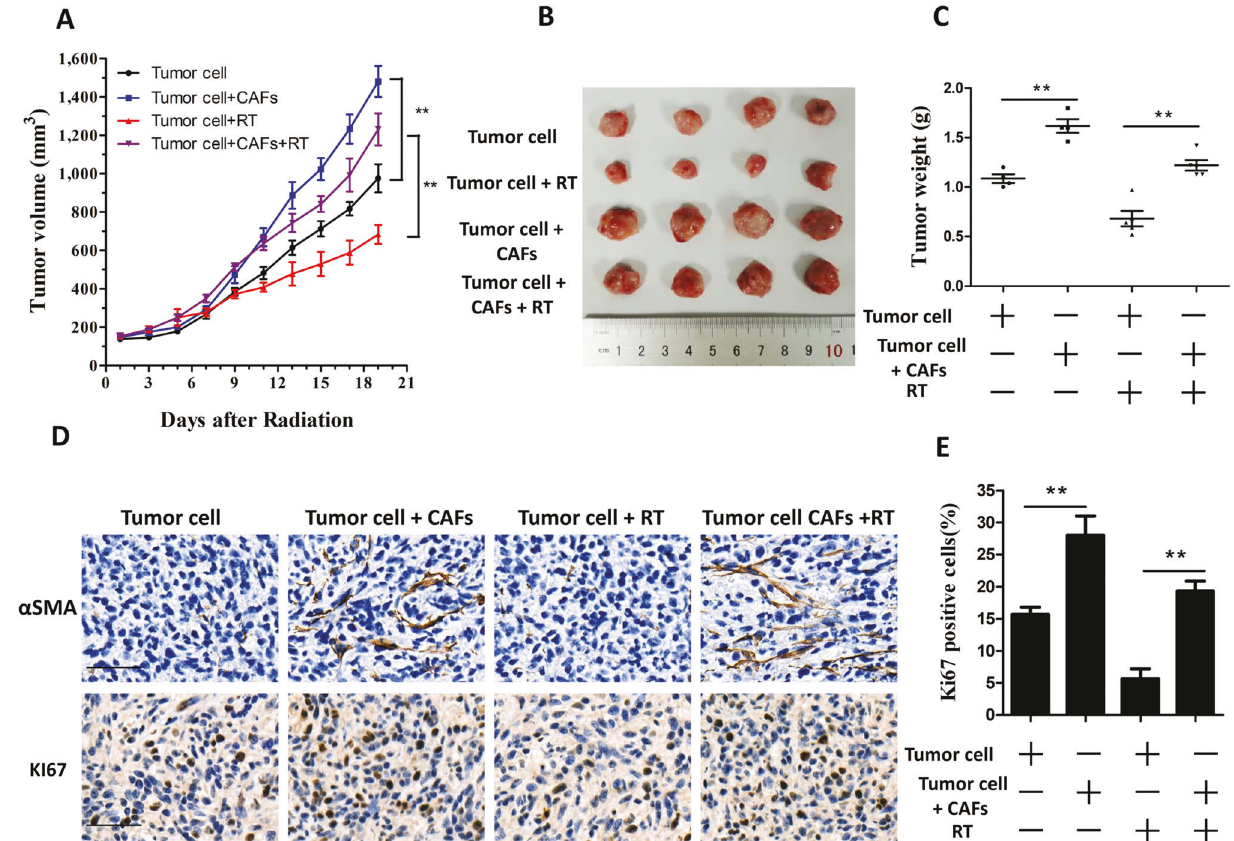
Fig. 2 CAFs facilitated the radioresistance and growth of breast cancer cells in vivo. A MDA-MB-231 cells (1 × 10 5 ) alone or mixed with CAFs (4 × 10 5 ) were implanted into the right limb of nude mice. When the tumors grew to 150 mm 3 , the tumors were exposed daily to 2 Gy radiation for fi ve treatments. The tumor volume was monitored every 2 days. Data points indicate the average tumor volume (mm 3 ) in each group ( n = 4); bars, SE. * P < 0.05, ** P < 0.01. B Image of tumors obtained from the nude mice. C The weights of the tumors obtained from the nude mice. Data points indicate the average tumor weight (g) in each group ( n = 4); bars, SE. * P < 0.05, ** P < 0.01. D , E IHC labeling of α SMA and KI67 in tumors derived from the nude mice. Scale bars, 50 μ m. Results are shown as means ± SD, n = 3, * P < 0.05, ** P <